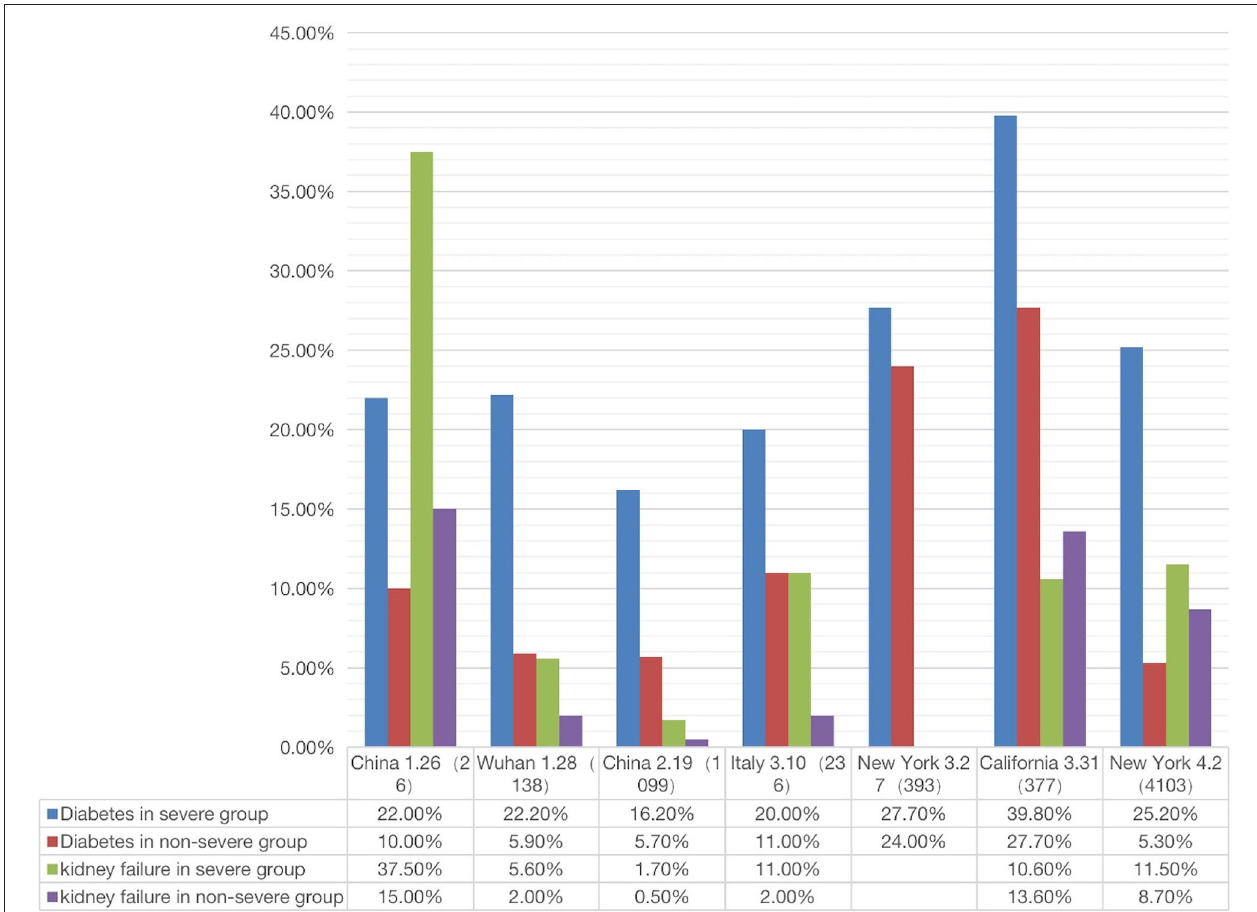
FIGURE 5 | Correlation between two comorbidity phenotypes (diabetes and kidney failure) and two outcomes (severe or non-severe) (see Supplementary File 3 ). In severe disease patients, the incidence of diabetes or kidney failure was higher than that in non-severe patient groups (The X-axis is country/city, report date, number of